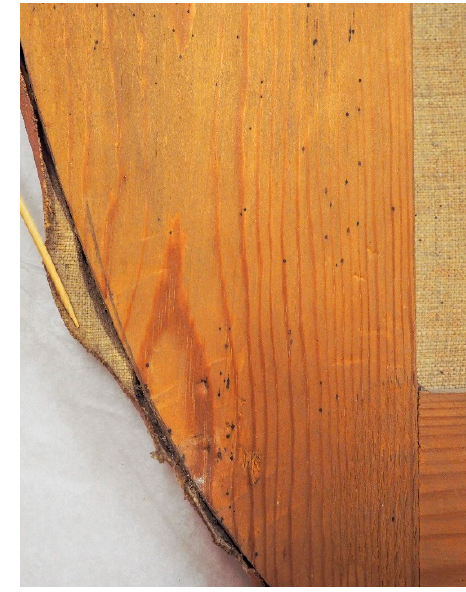
Figure 10. Symmetrically located holes (indicated by arrows) on the minor axis in each side of the strainer on of E. Moltke (SV6). Similar holes and positioning on the minor axis are also visible on the strainers of A.M.B. Neergaard (SV2), J.P.B. Neergaard (SV4), and J. Moltke (SV5).